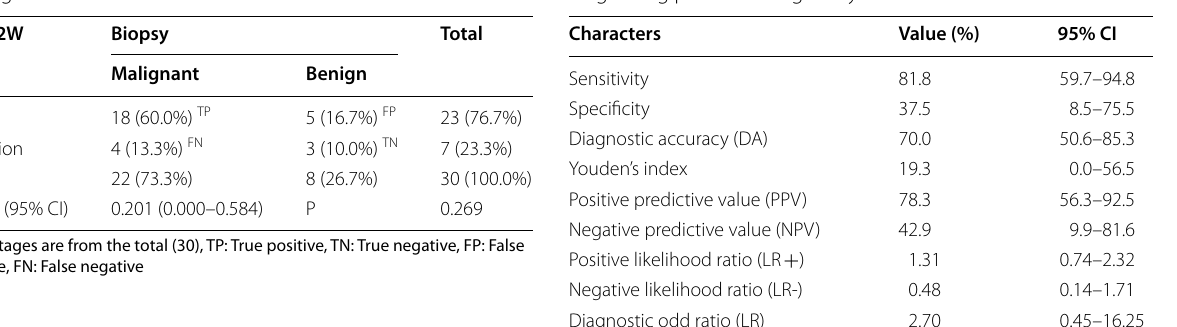
Table 4 Agreement between biopsy (reference) and MRI T2W findings